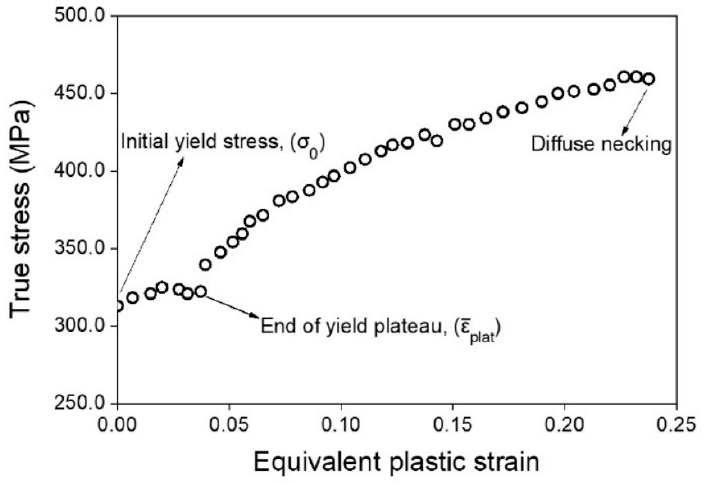
Figure 5. True stress-equivalent plastic strain curve of JIS G3131 SPHC.